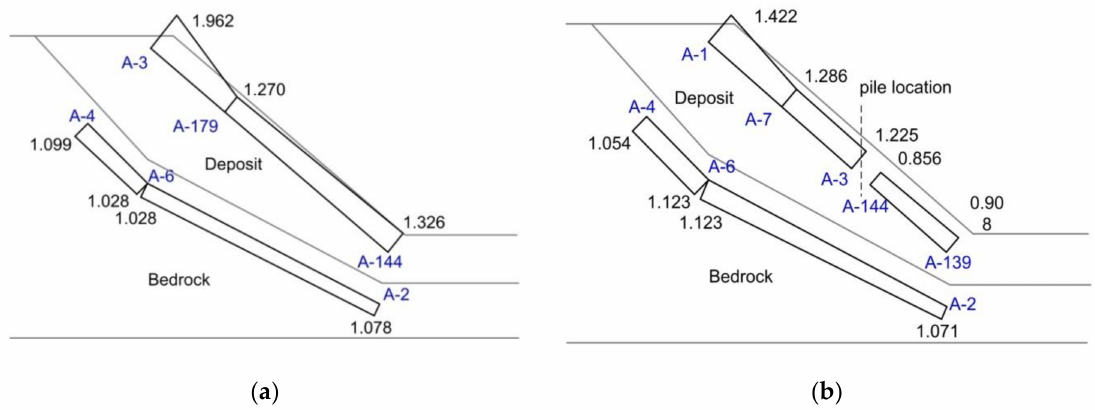
Figure 9. Average horizontal PGA amplification factor distribution in the underlying bedrock deposit slope in centrifuge tests: ( a )1#model; ( b ) 2# model.